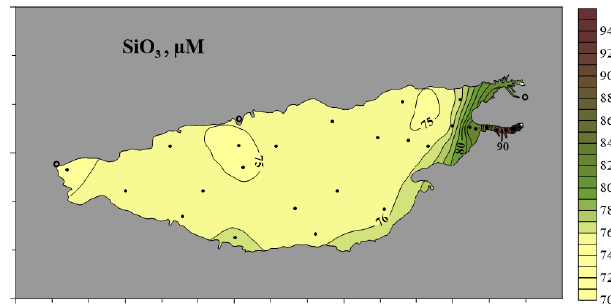
Figure 10. Concentration of silicates (µM) at the lake surface in November of